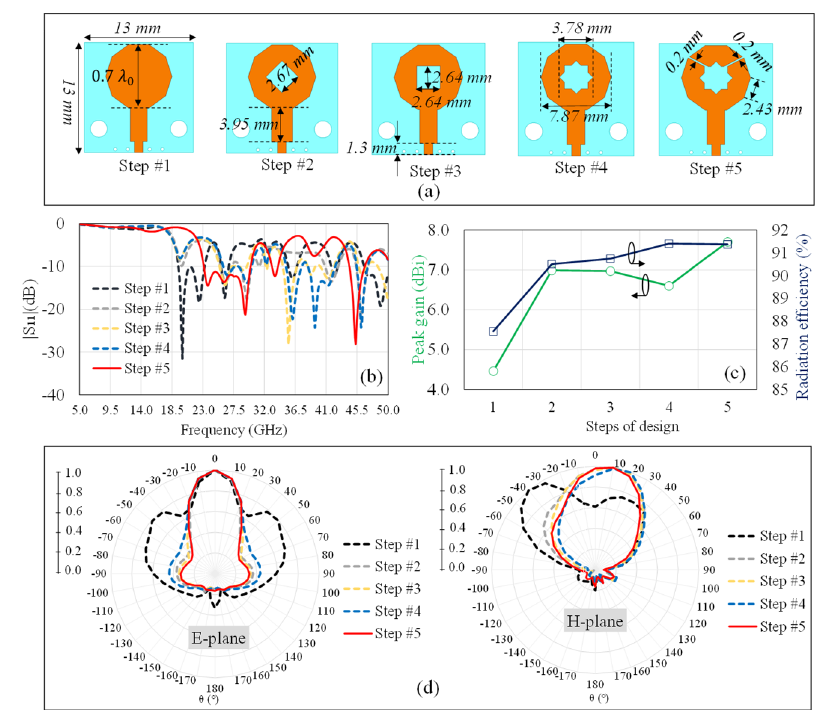
Figure 3. Design evolution and comparison of ( a ) Steps of the design process and antenna dimensions; ( b ) Return loss; ( c ) Peak gains and radiation efficiencies at 28 GHz; and ( d ) 2D—normalized radiation patterns at 28 GHz.